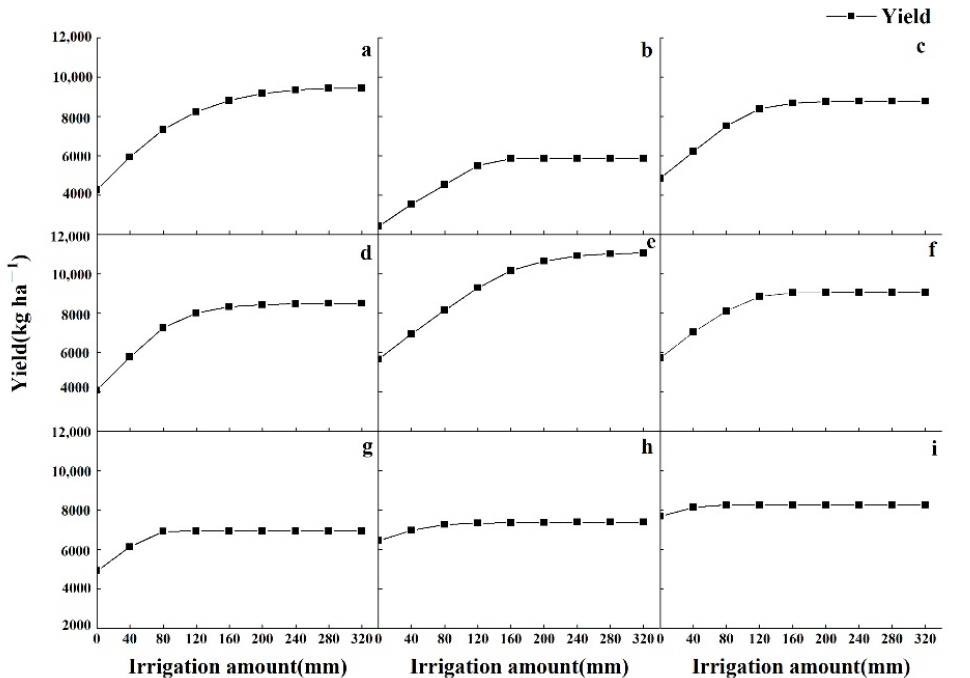
Figure 2. Changes in winter wheat yield with irrigation levels in the North China Plain. ( a ) Tangshan, ( b ) Huanghua, ( c ) Luancheng, ( d ) Huimin, ( e ) Nangong, ( f ) Ganyu, ( g ) Shangqiu, ( h ) Zhumadian, ( i ) Shouxian.